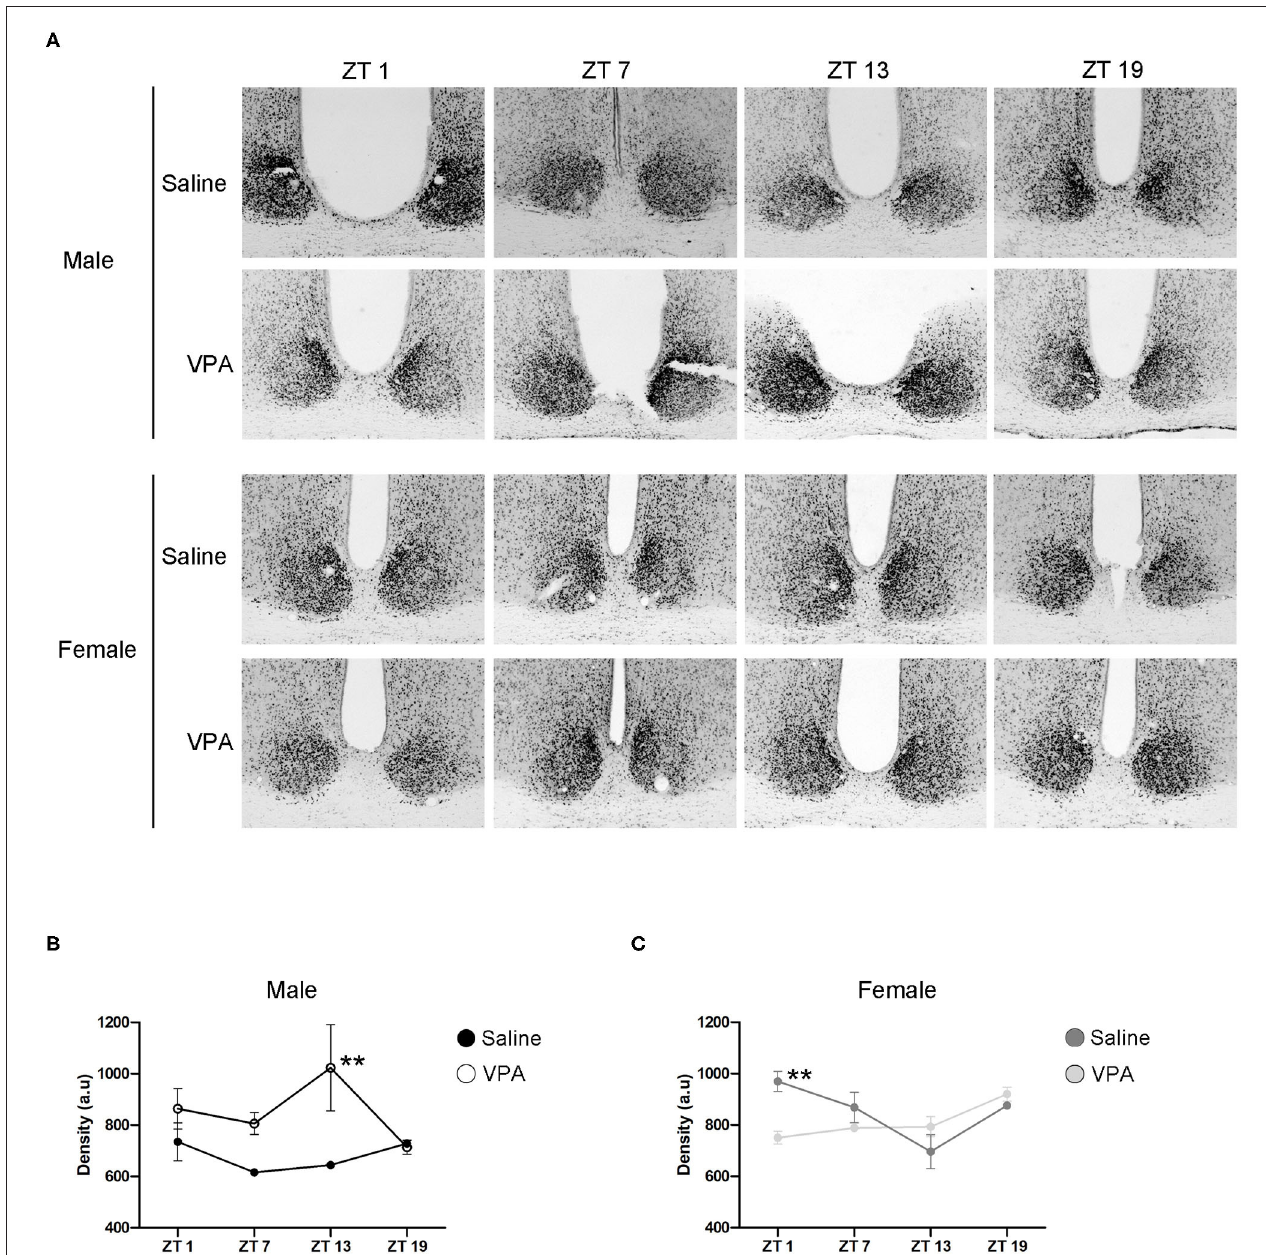
FIGURE 6 | In utero exposure to VPA alters the expression of BMAL1 within the SCN. (A) Representative images of BMAL1 immunoreactivity within the SCN of saline and VPA-exposed males (upper panels) and females (lower panels) across a 24h period (ZT 1, 7, 13, 19), where n = 3/time point/condition in both sexes. (B) Differential BMAL1 expression within the SCN of VPA-exposed males [two-way ANOVA, significant main effect of treatment. F (1, 14) = 15.10, p = 0.0016]. Planned comparisons revealed a significant difference at ZT 13 between groups ( p = 0.0044). (C) BMAL1 expression within the SCN of VPA-exposed females is altered compared to saline-exposed females [two-way ANOVA, significant interaction of treatment × time. F (3, 16) = 6.227, p = 0.0053]. Planned comparisons revealed a significant difference in BMAL1 expression at ZT 1 between groups ( p = 0.0053). Data was analysed using a two-way ANOVA and a Bonferroni planned comparison of time points. ** p ≤